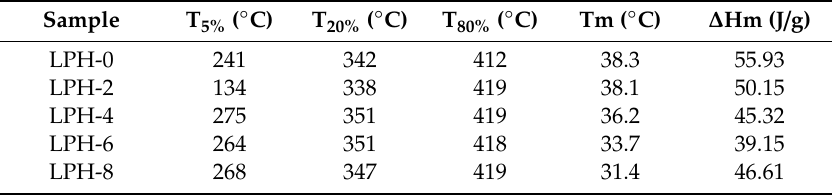
Table 2. Thermal parameters of LPH films by TGA and DSC measurements.